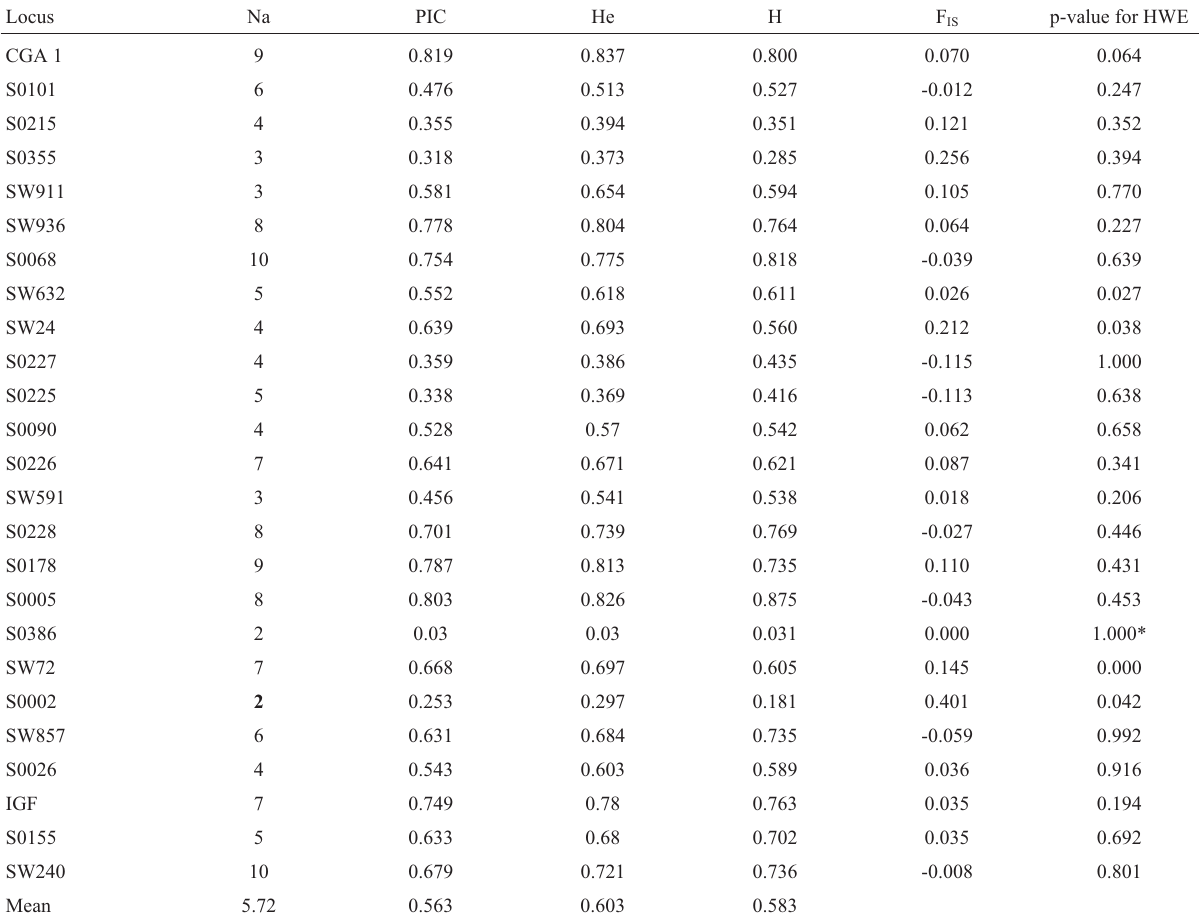
Table 1 - Details of 25 microsatellite loci typed in Pampa Rocha pigs.